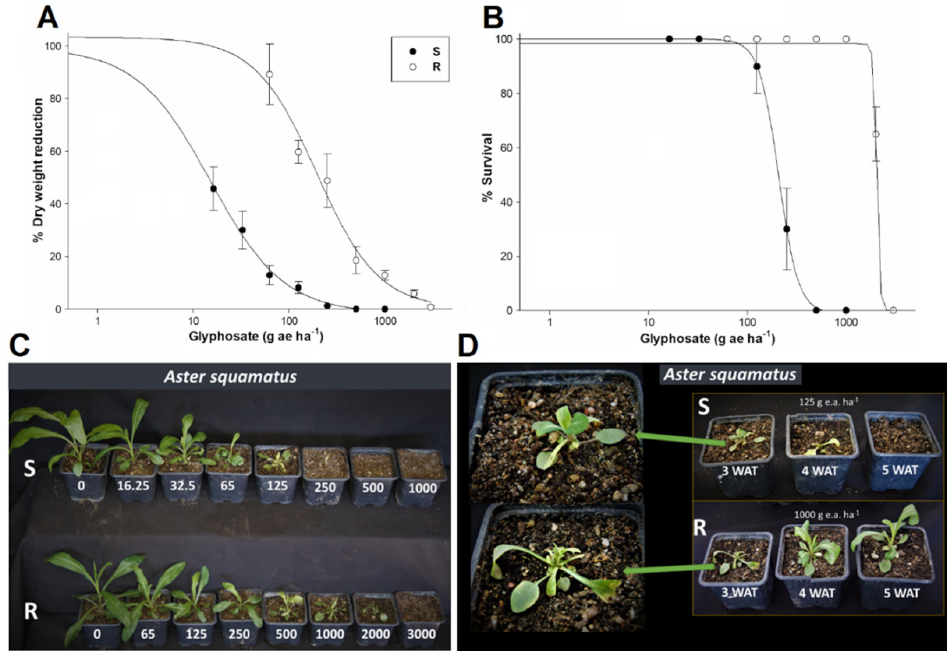
Figure 1. Glyphosate dose-response curves of the dry weight reduction ( A ) and plant survival ( B ) in susceptible (S) and resistant (R) saltmarsh aster ( A. squamatus ) populations treated with different glyphosate doses (g ae ha − 1 ). Vertical bars are the SEM ( n = 10 for weight reduction and n = 2 for plant survival). ( C ) R and S plants at 4 weeks after treatment (WAT) of glyphosate. ( D ) Regrowth of S and R plants treated with 125 and 1000 g ae ha − 1 glyphosate, respectively, at different WATs. Table 1. Parameters of the three-parameter log-logistic equation a used to estimate the weight reduction, plant mortality or enzyme activity inhibition by 50% in glyphosate-susceptive (S) and -resistant (R) saltmarsh aster populations. Dose-Response